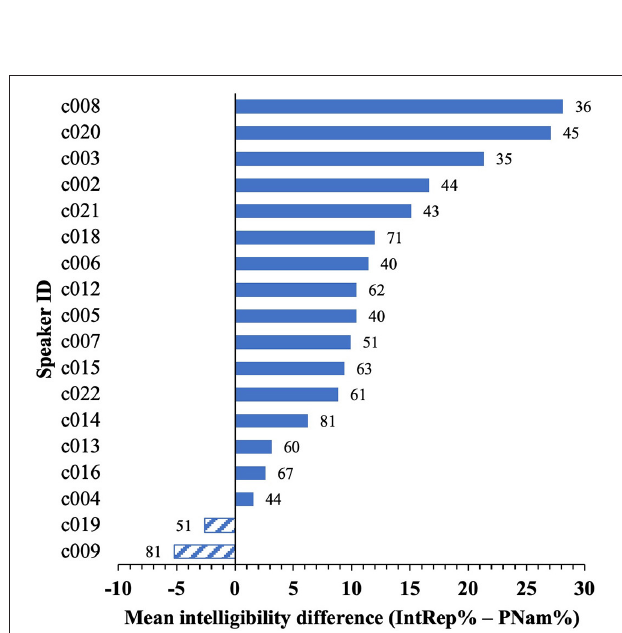
FIGURE 2 | By-speaker differences between mean intelligibility scores on the two tasks for the 16 included items. Data labels are the PNam% scores.